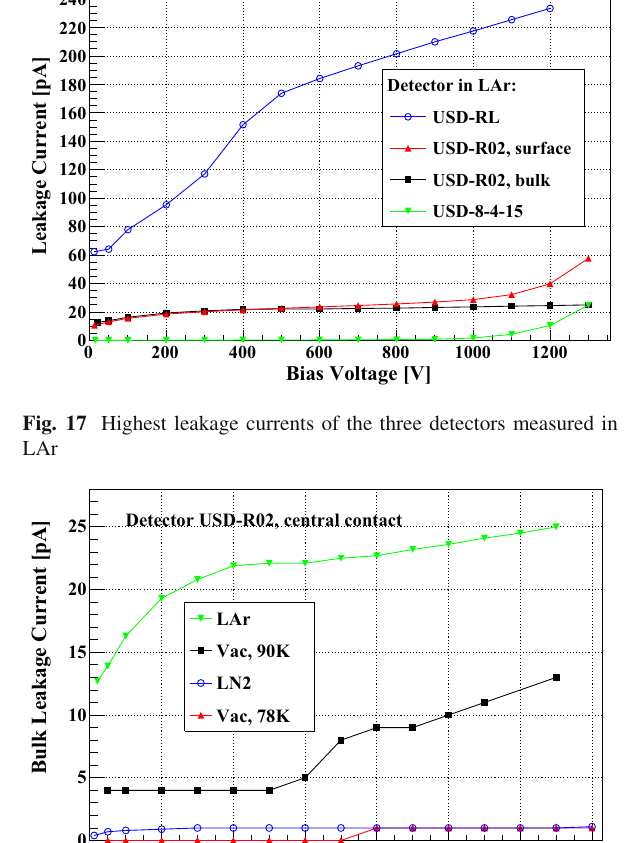
The precision of the experimental setup was not enough to tell the subtle difference at that